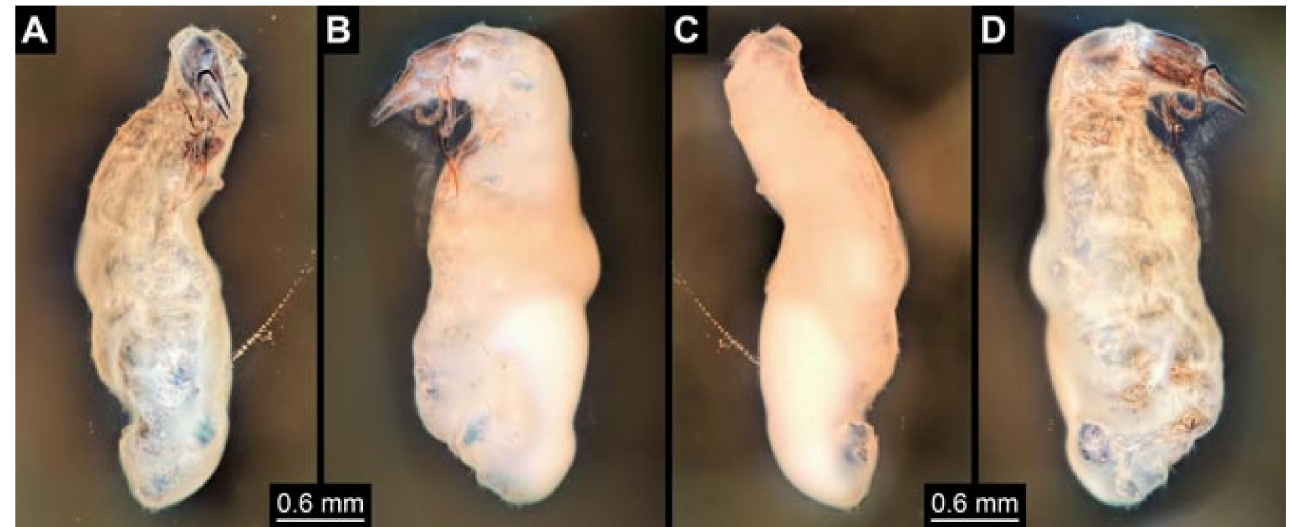
Figure 2. Specimen 5814 (SMF 1297); Baltic amber. ( A ) Ventral view. ( B ) Ventro-lateral view. ( C ) Dorsal view. ( D ) Dorso- lateral